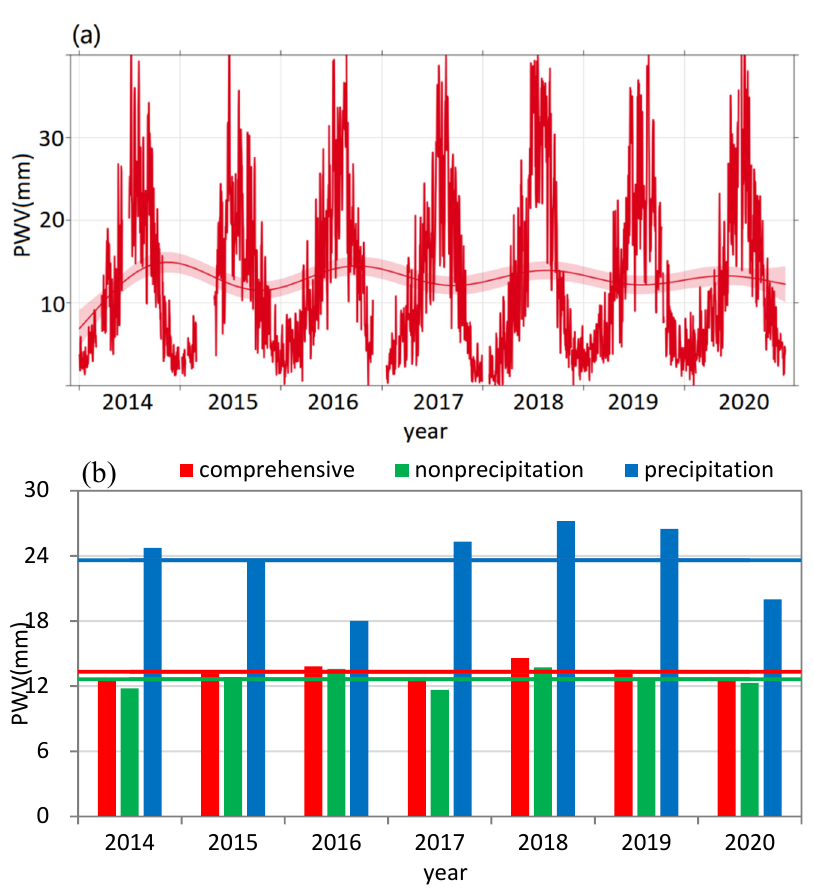
Figure 4. Interannual change PWV of LPM area from 2014 to 2020. ( a ) PWV Change line graphs in